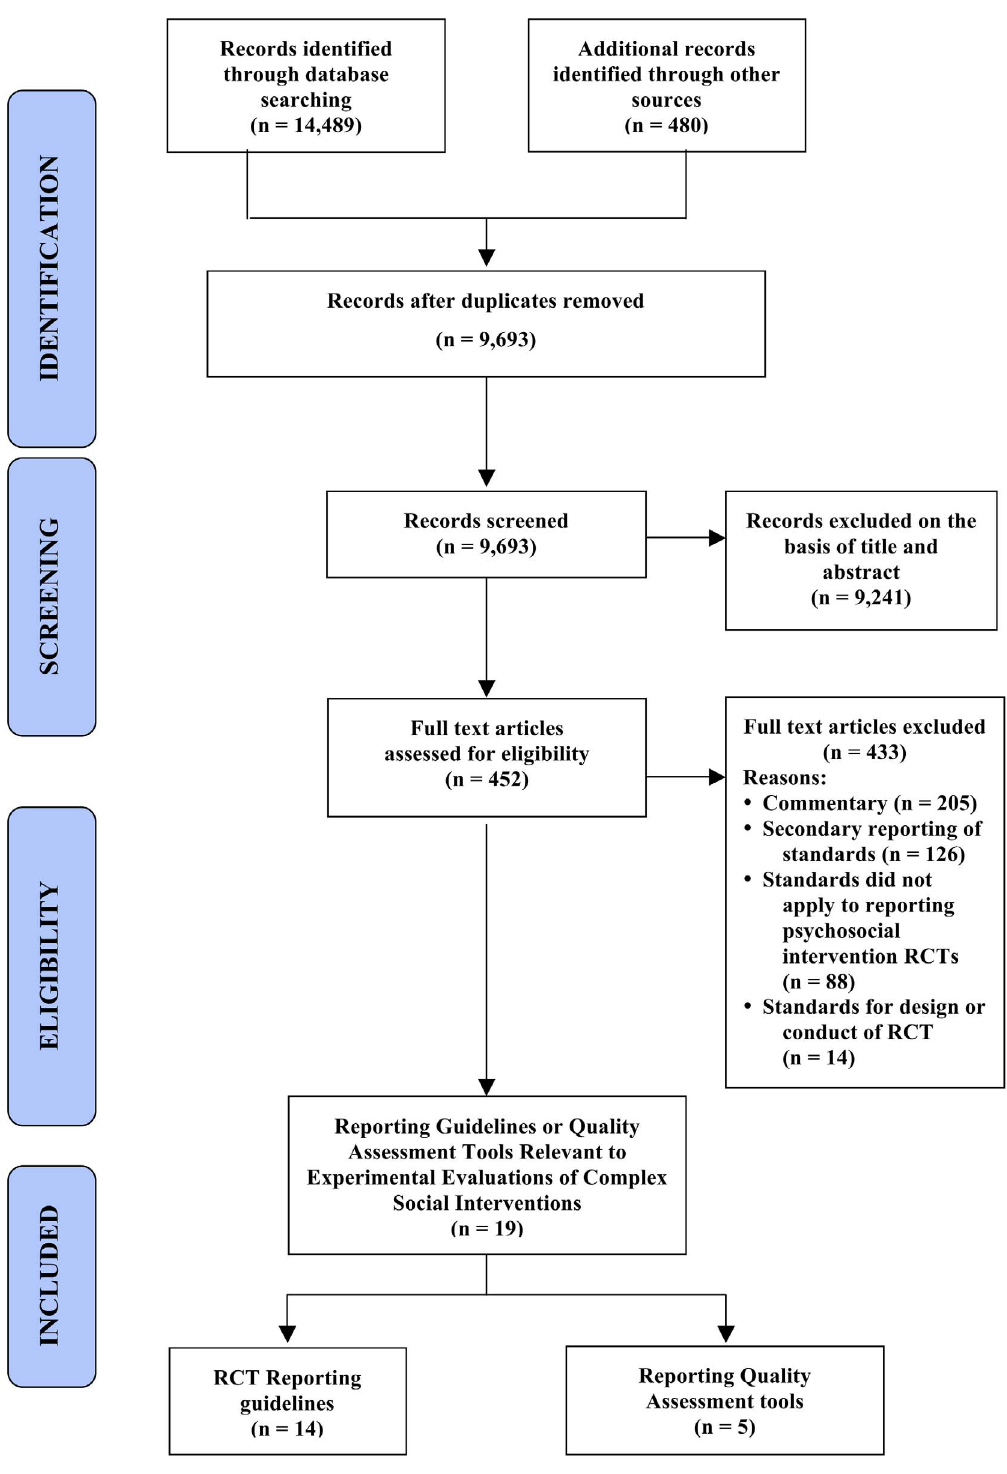
Figure 1. Flowchart of reporting guidelines through systematic literature search.